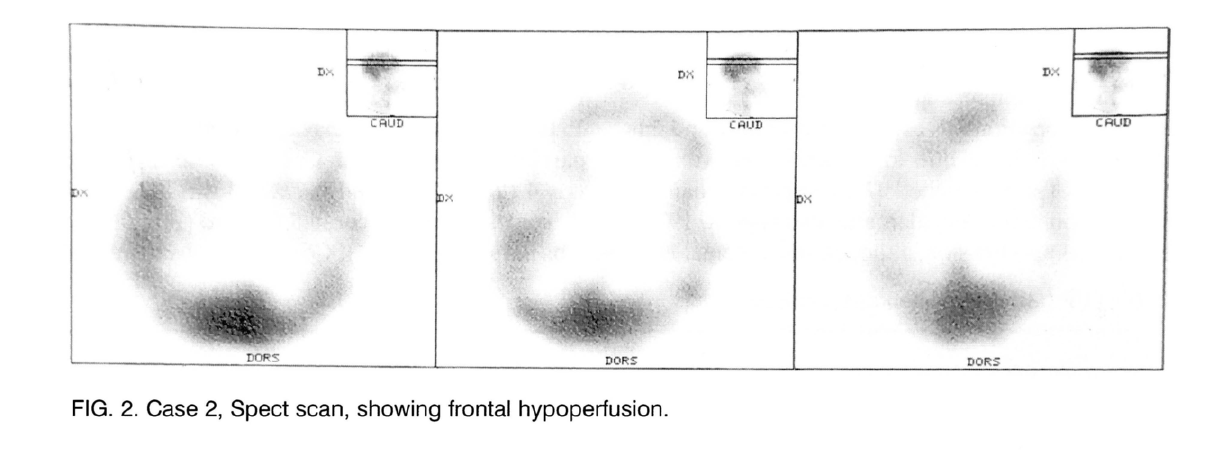
FIG. 2. Case 2, Spect scan, showing frontal